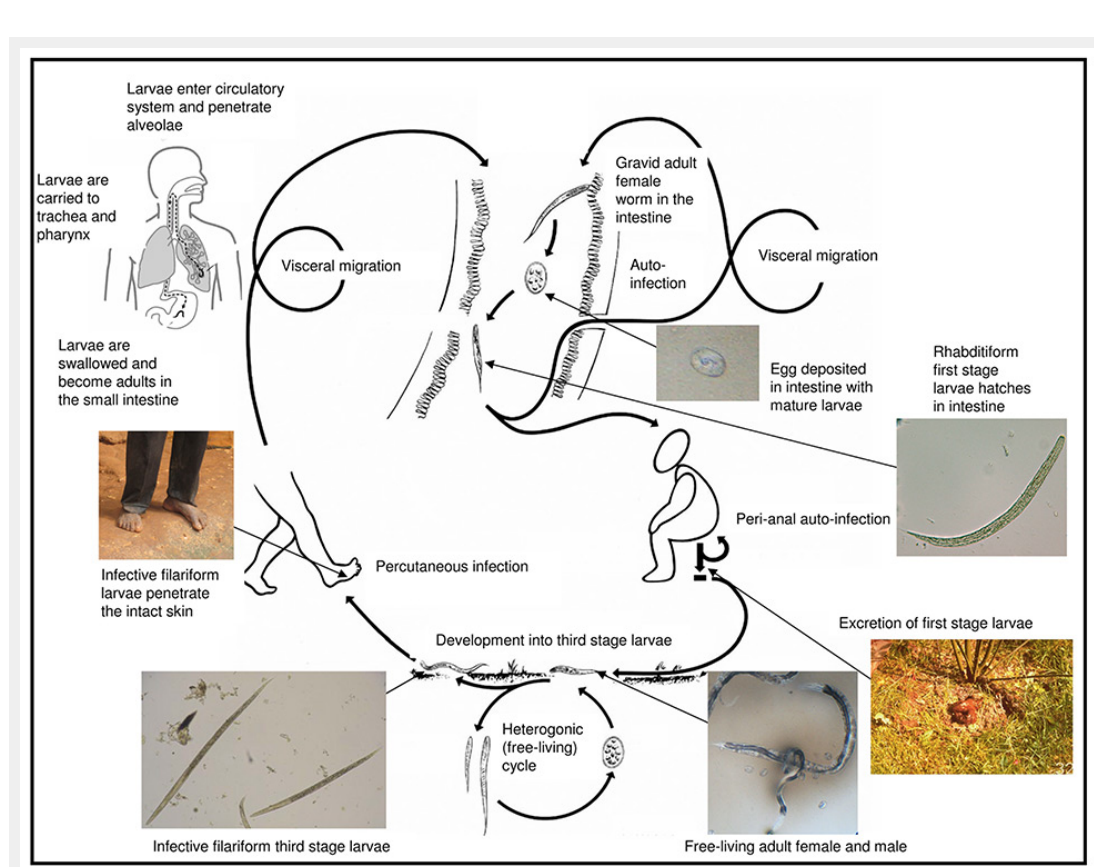
Life cycle of Strongyloides stercoralis . (Adapted from Olsen A, van Lieshout L, Marti H, Polderman T, Polman K, Steinmann P, et al. Strongyloidiasis – the most neglected of the neglected tropical diseases? Trans R Soc Trop Med Hyg. 2009;103:967–72 [85]. © Elsevier, 2009. Printed with